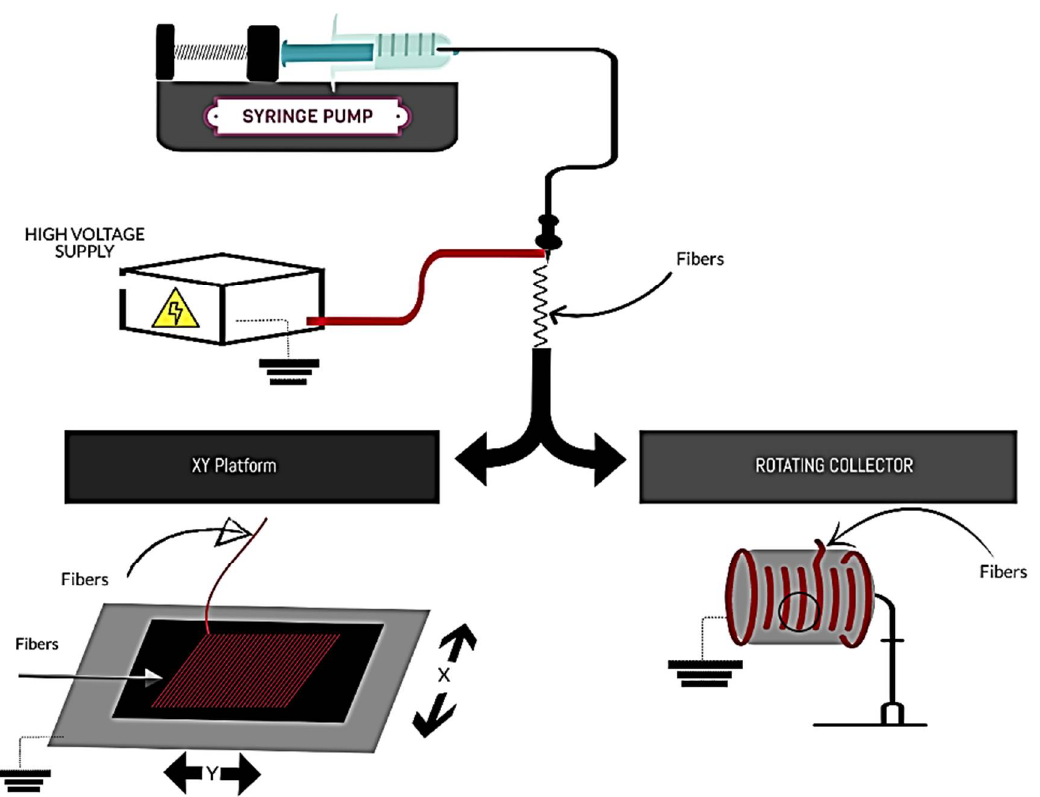
Figure 1. Schematic illustration of the electrospinning process performed: XY platform (flat collector platform with movements in the X and Y axes) vs rotary collector.